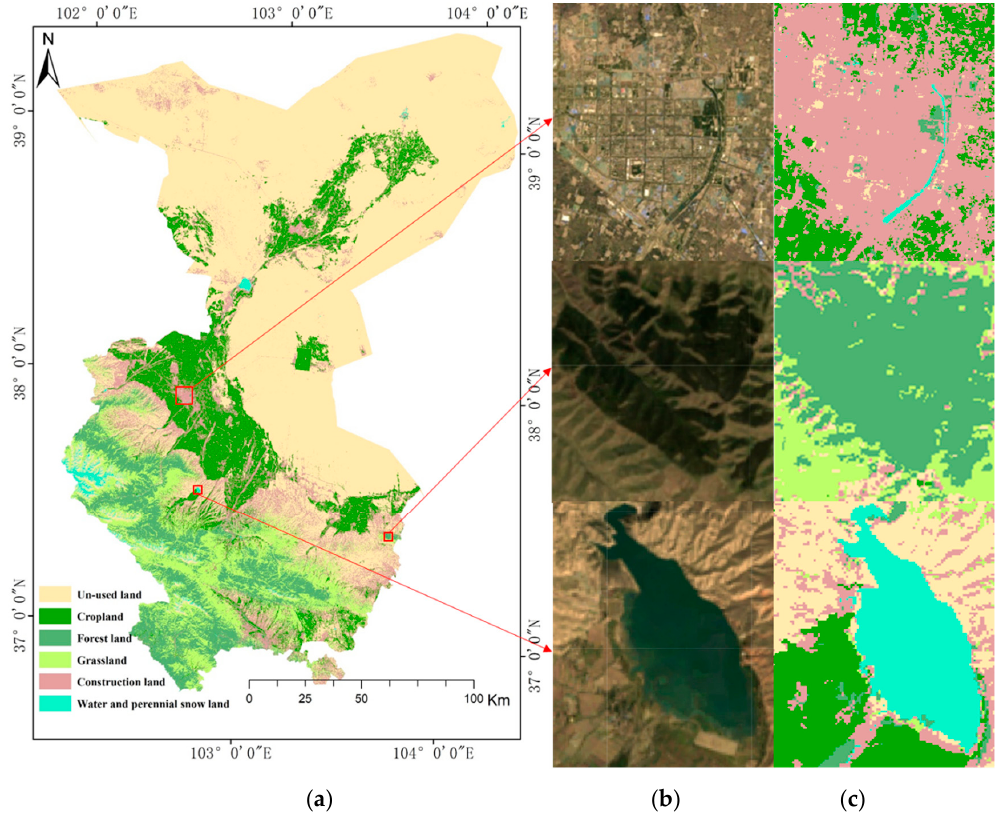
Figure 5. The classification results of 2019: ( a ) the land cover classification results of study area in 2019: ( b ) partial true color images of study area in 2019: ( c ) partial land cover classification detailed result of study area in 2019. Table 3. Accuracy assessment for basic year classification.